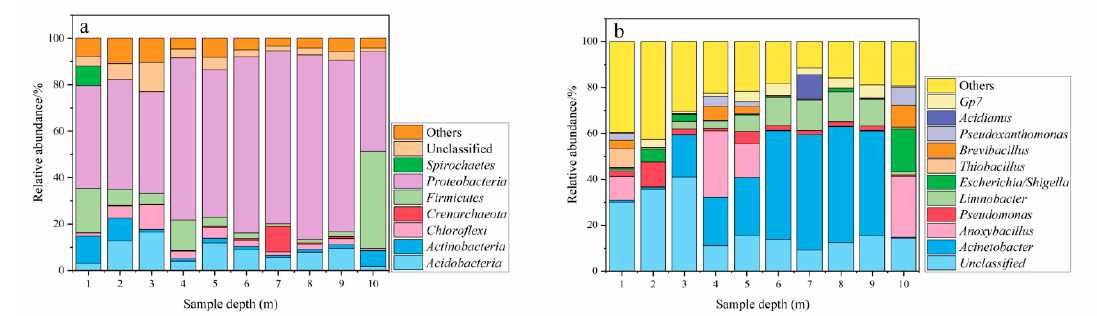
Figure 7. Relative abundance (%) of dominant bacteria and archaea in vertical soil samples at phylum level ( a ) and genus level ( b ).